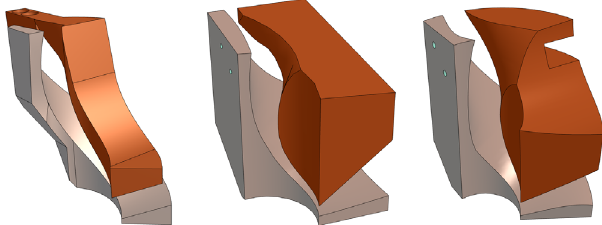
FIG. 11. 3D models of the C-inflectors, as they were manu- factured: C1 (left), C2 (middle) and C3 (right). C1 has parallel Þ plane, C2 has straight nonparallel lines, ; h electrodes in the ð u r r and C3 has quadratic lines. For C2 the entrance and exit edges are not perpendicular to the central path.